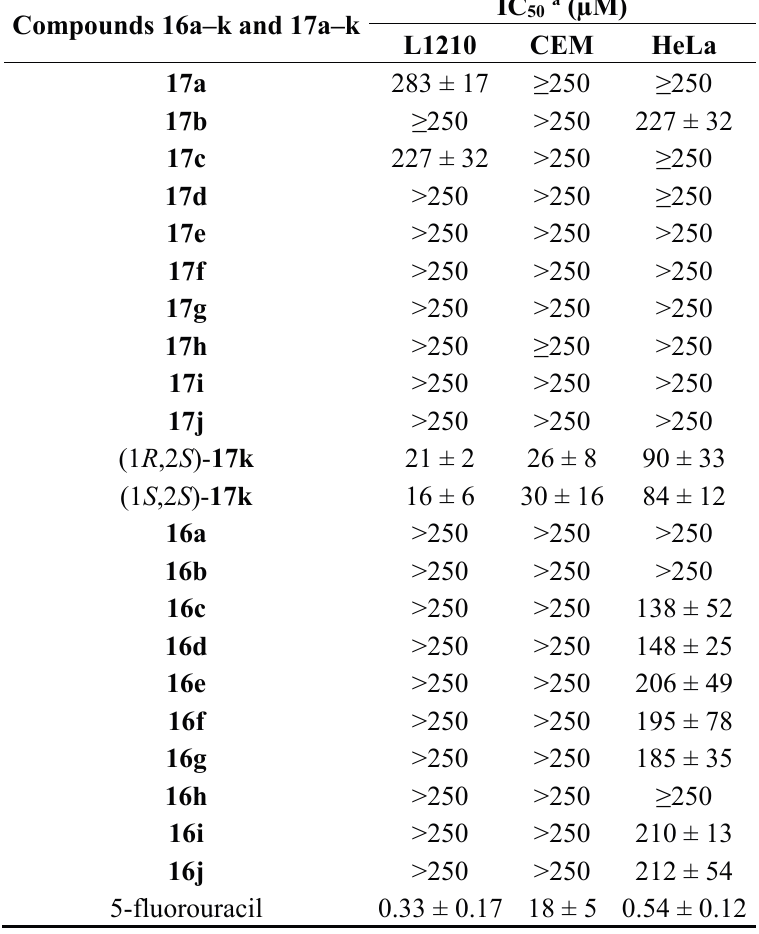
Table 1. Inhibitory effect of the tested compounds against the proliferation of murine leukemia (L1210), human T-lymphocyte (CEM) and human cervix carcinoma cells (HeLa). Compounds 16a–k and